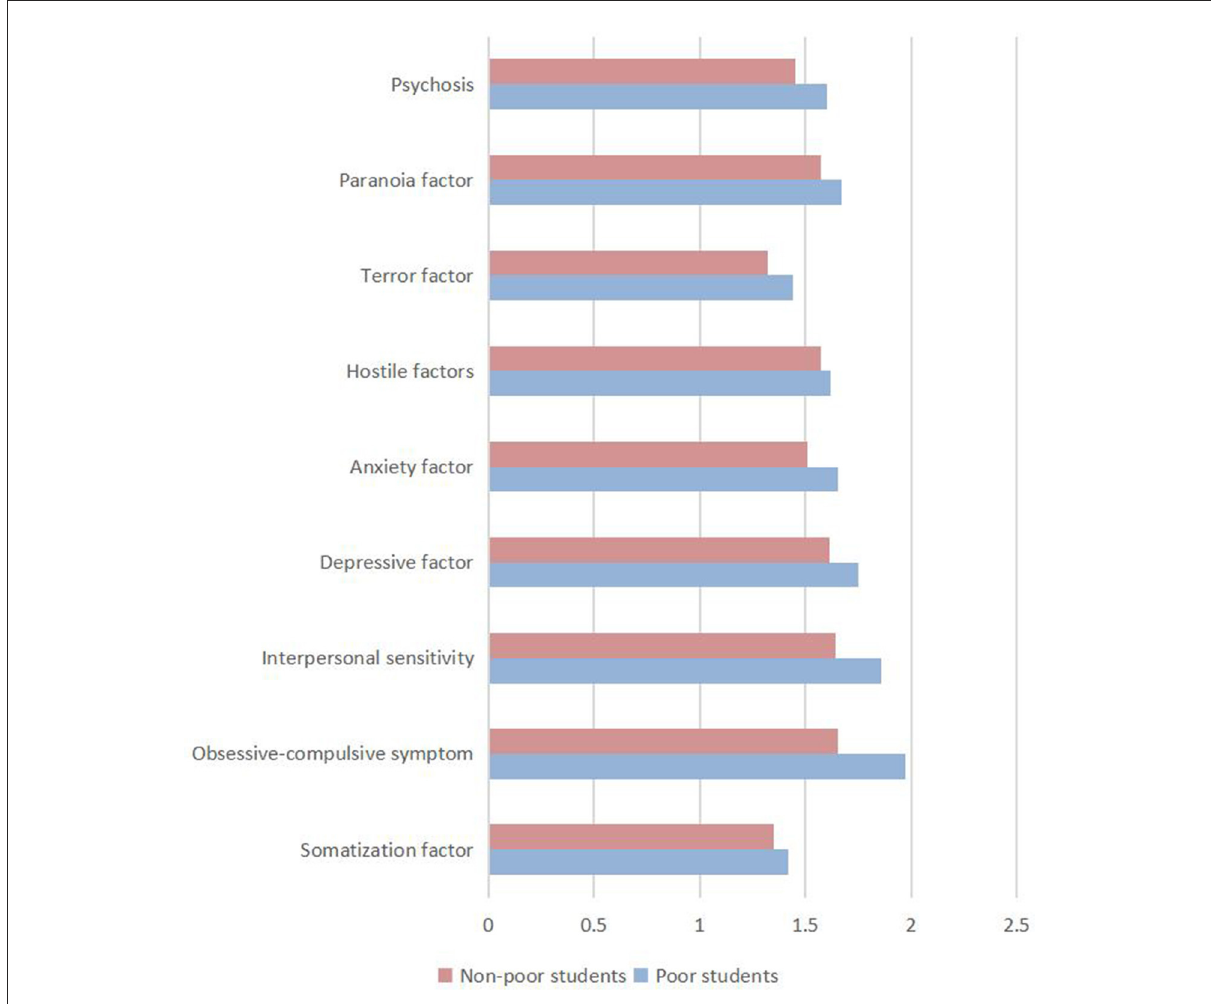
FIGURE1 The results of SCL-90 factors for poor and non-poor